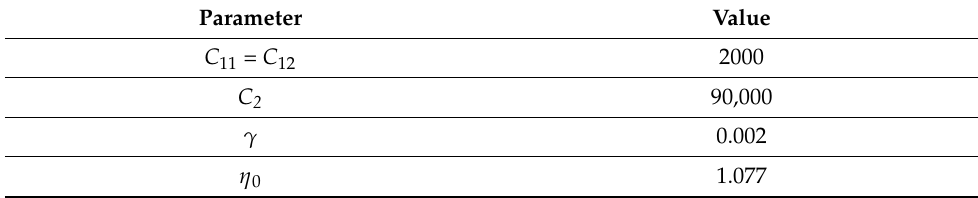
Table 5. The design control